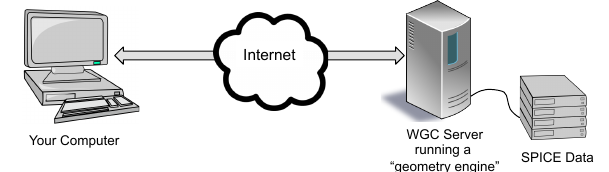
Figure 2 Architecture of the WebGeocalc Tool